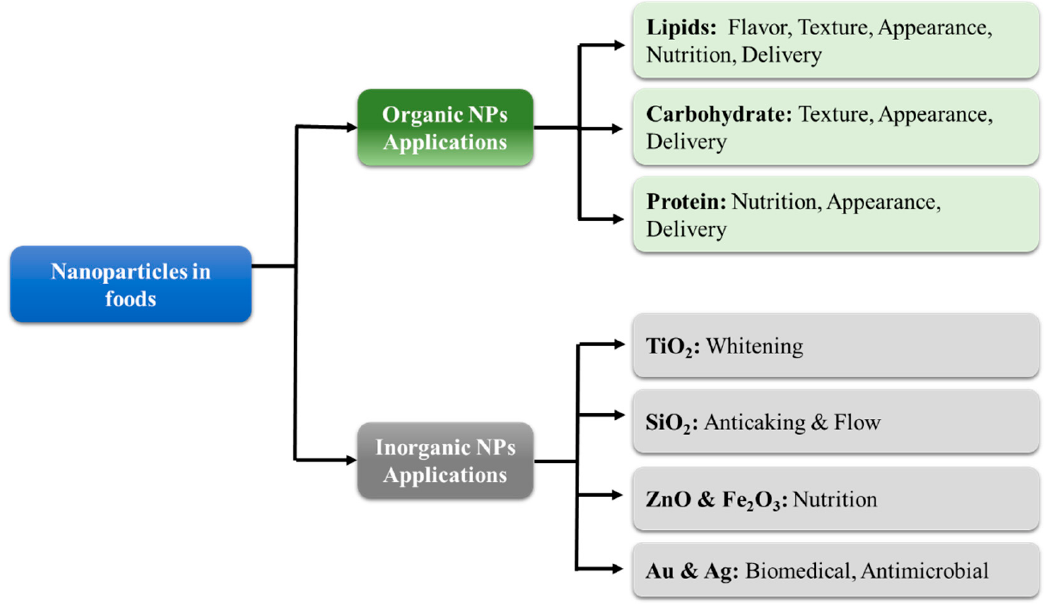
Figure 3. The categories and applications of organic and inorganic nanoparticles in foods.